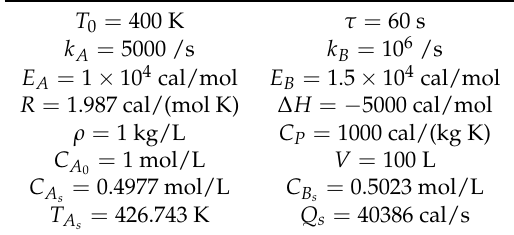
Table 1. Parameter values and steady-state values for the continuous stirred tank reactor (CSTR) case study.